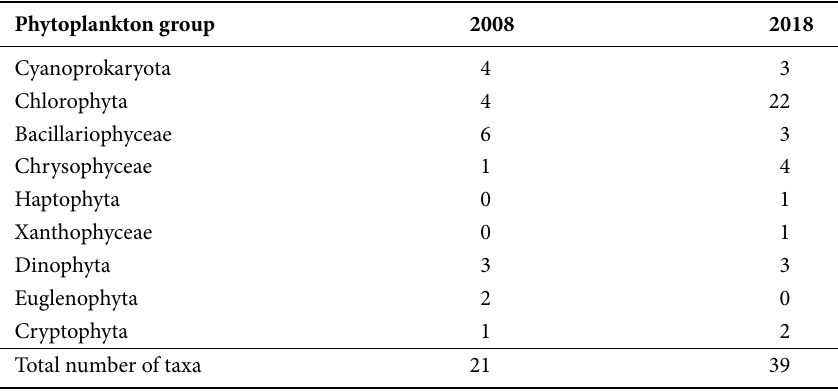
Table 2 Number of phytoplankton taxa, including taxonomic groups in 2008 and